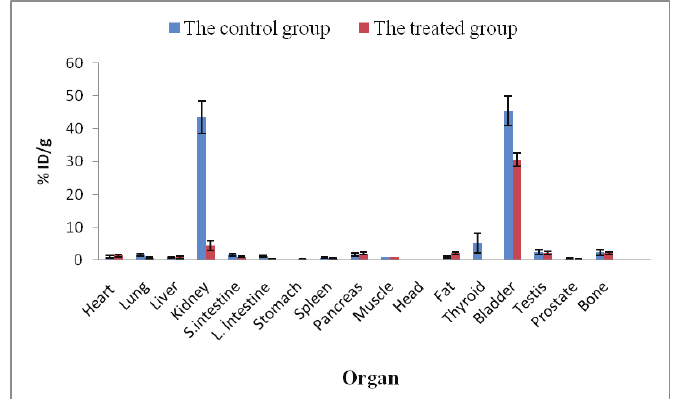
FIGuRE 5 - %ID/g of 99m Tc-GH for Wistar albino